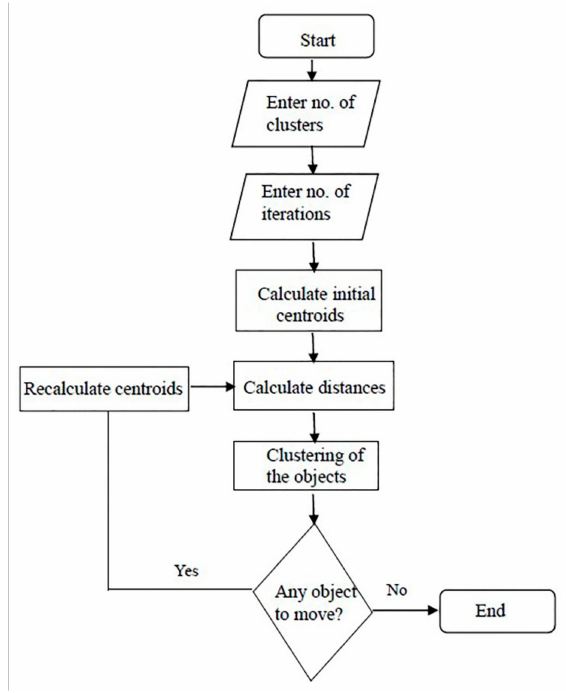
Figure 4. Flow chart of the K-means